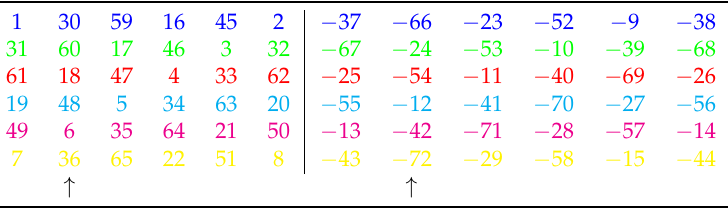
Table 25. WDT of a 6-phase reduced winding with N = 96, p = 5, q = 1 + 2 / 10 , after swapping.